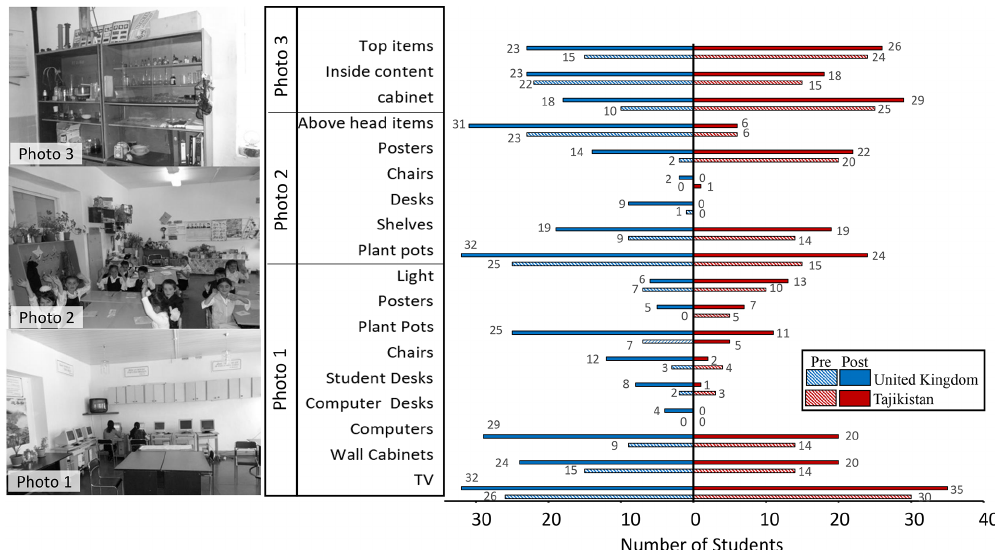
Figure 6. Students’ understanding of non-structural hazards. From left to right: photographs used in questionnaires for non-structural hazard identification, items identified correctly as non-structural hazards, and pre- and post-assessment results. Photo credit: AKDN/DRMI, 2011 (https://www.akdn.org/, last access: 19 May